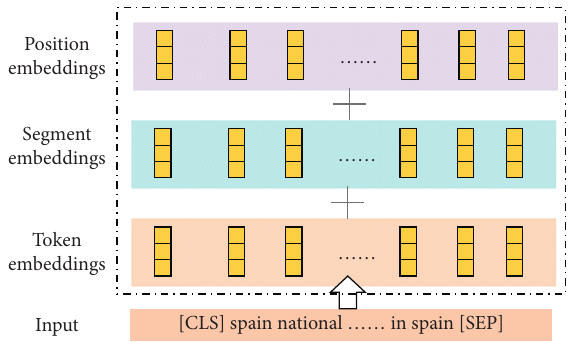
Figure 3: The input